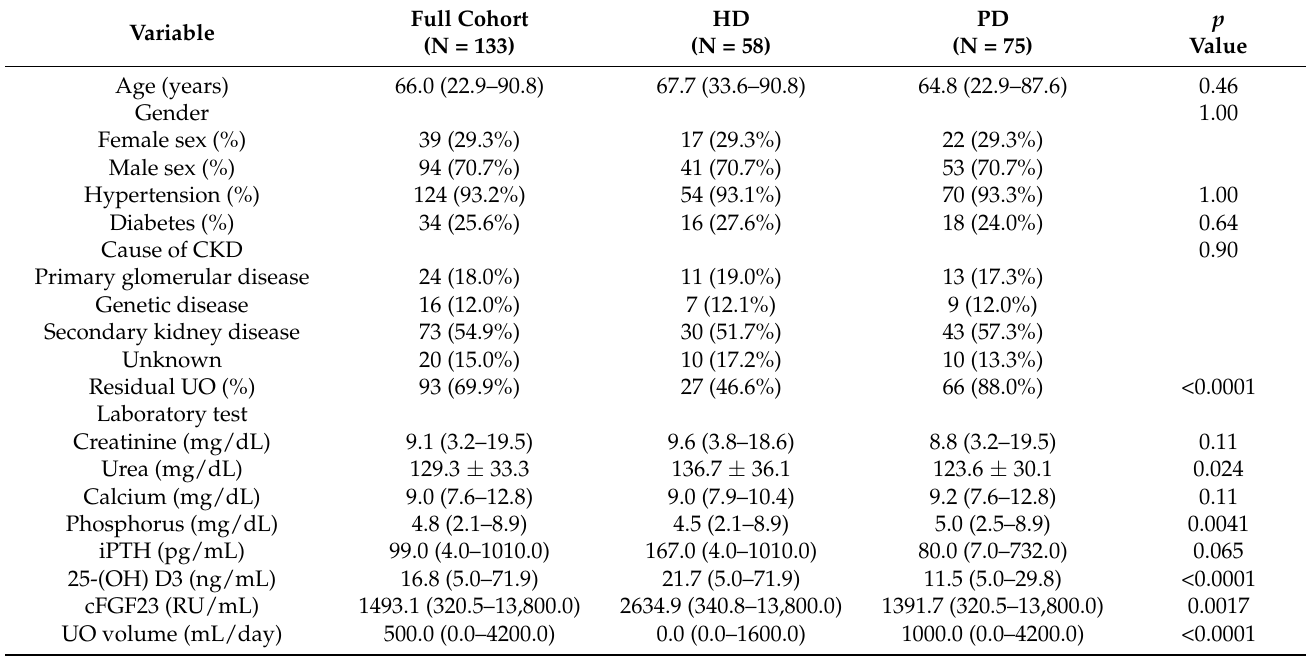
Table 1. Characteristics of the full cohort, i.e., the hemodialysis (HD) and peritoneal dialysis (PD) patients.